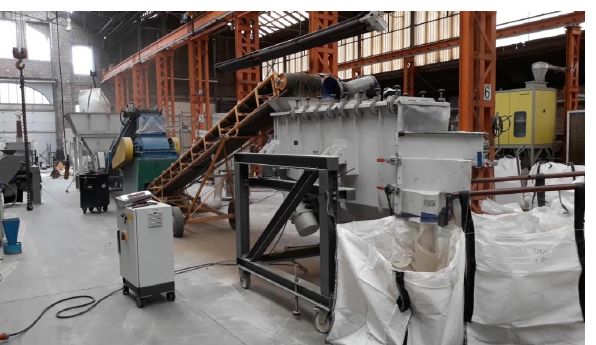
Figure 14. Step of fluted roll crushing (in the back) with the 10 mm sieve directly connected (in the front).